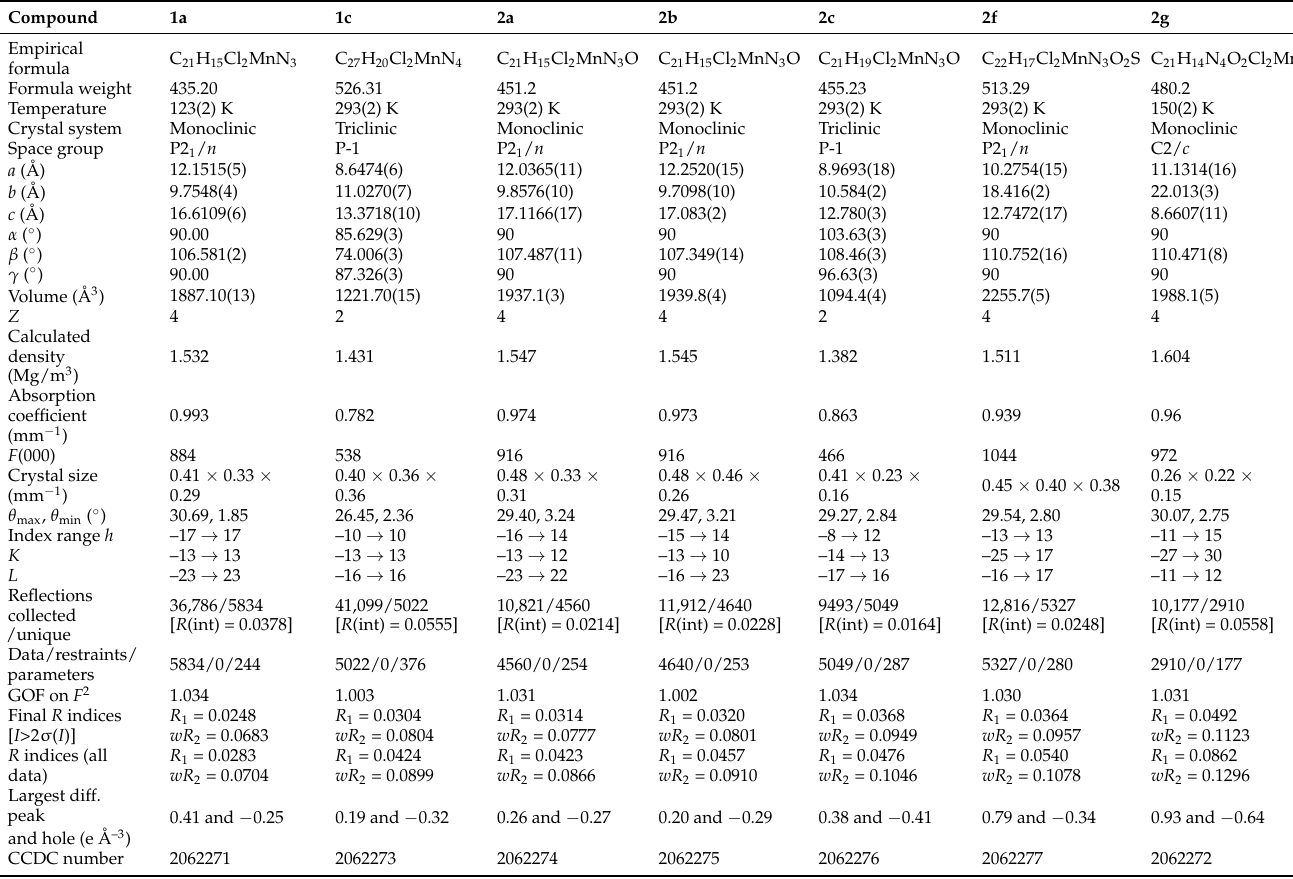
Table 4. Hydrogen bond interactions for compounds 1a , 1c , 2a – 2c , 2f and 2g